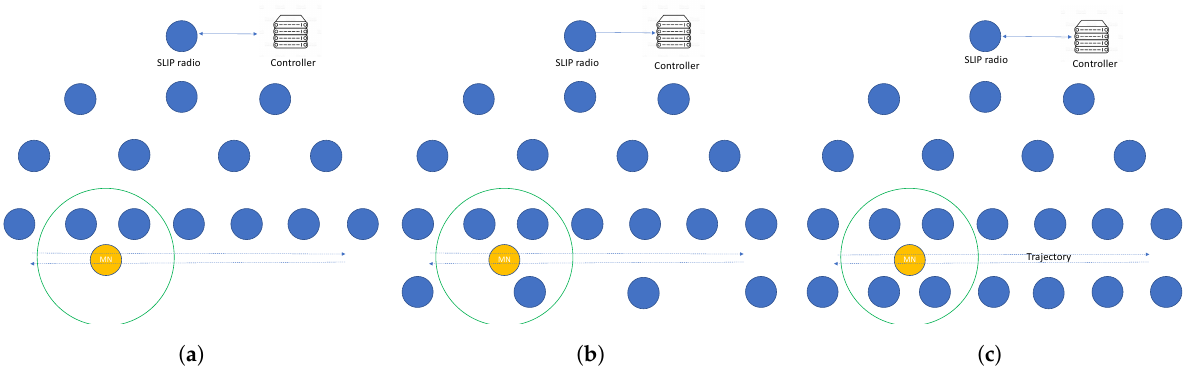
Figure 12. Simulation scenarios when increasing number of neighbors of a MN: ( a ) with 2 neighbors, ( b ) with 3 neighbors, and ( c ) with 4